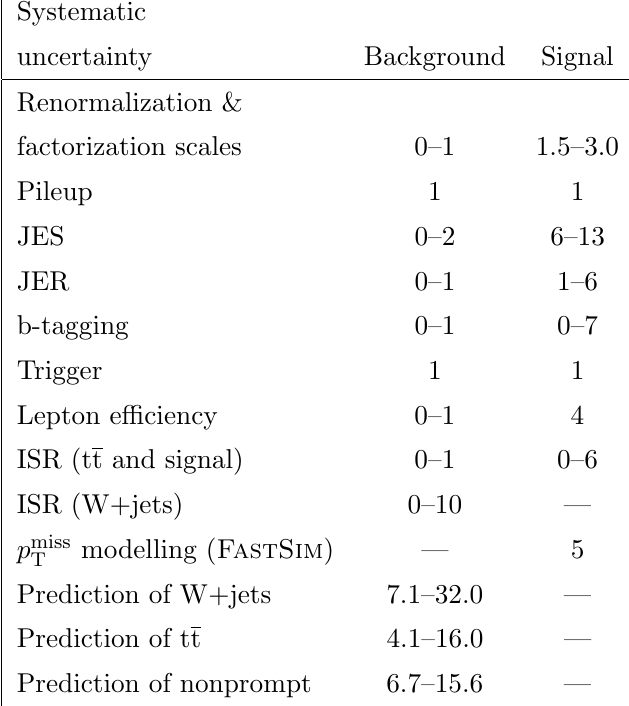
sets of results include the prediction of the W+jets and tt processes, the prediction of the background with a nonprompt lepton, the prediction of other background processes from simulation, the total expected background, and the observed number of data